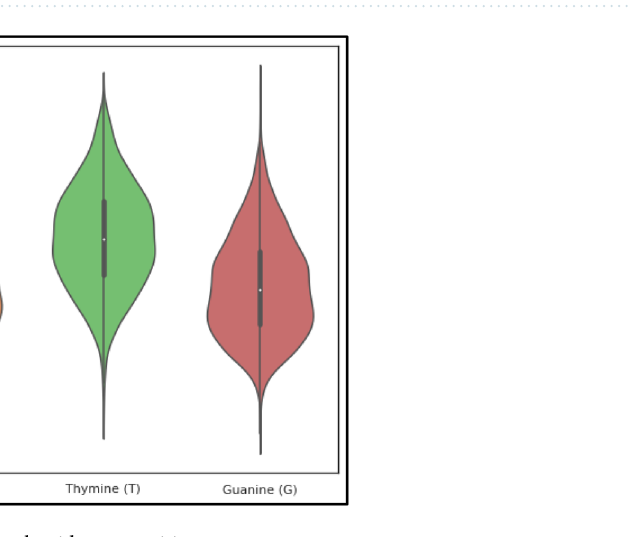
Figure 5. The violin plot of all four nucleotide